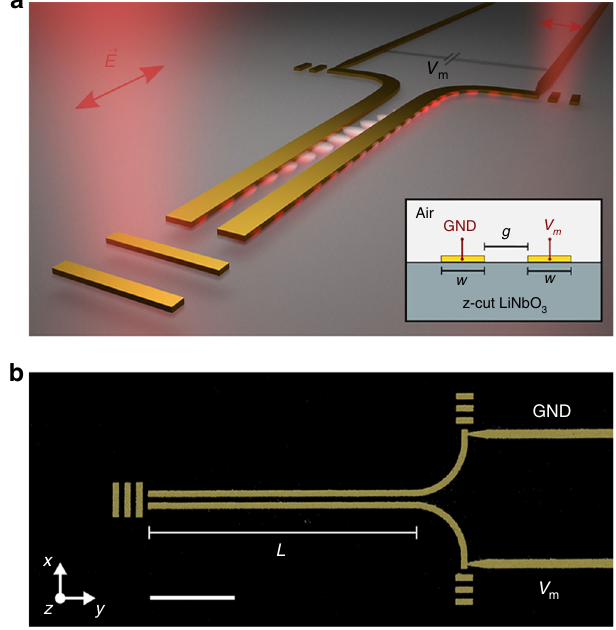
Fig. 1 Plasmonic monolithic lithium niobate directional coupler switch. a Conceptual image of power modulation in the plasmonic nanostripes by applying a bias voltage, which induces a refractive index change due to the electro-optic effect in the substrate. The inset shows the cross-section of the two identical parallel waveguides of width w = 350 nm, separated by a gap of g = 350 nm and placed on z -cut lithium niobate (LiNbO 3 , LN). b False-colored scanning electron microscope (SEM) image of the investigated plasmonic directional coupler switch. The scale bar represents 5 µ m. The optimal length L of interaction is chosen to be 15.5 µ